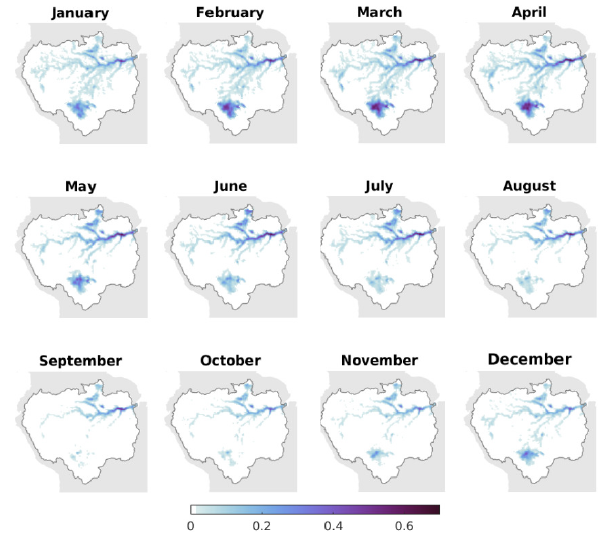
Figure 1. The Amazon River basin and its main tributaries mapped over the SRTM (Shuttle Radar Topography Mission – 500m) digital elevation model.